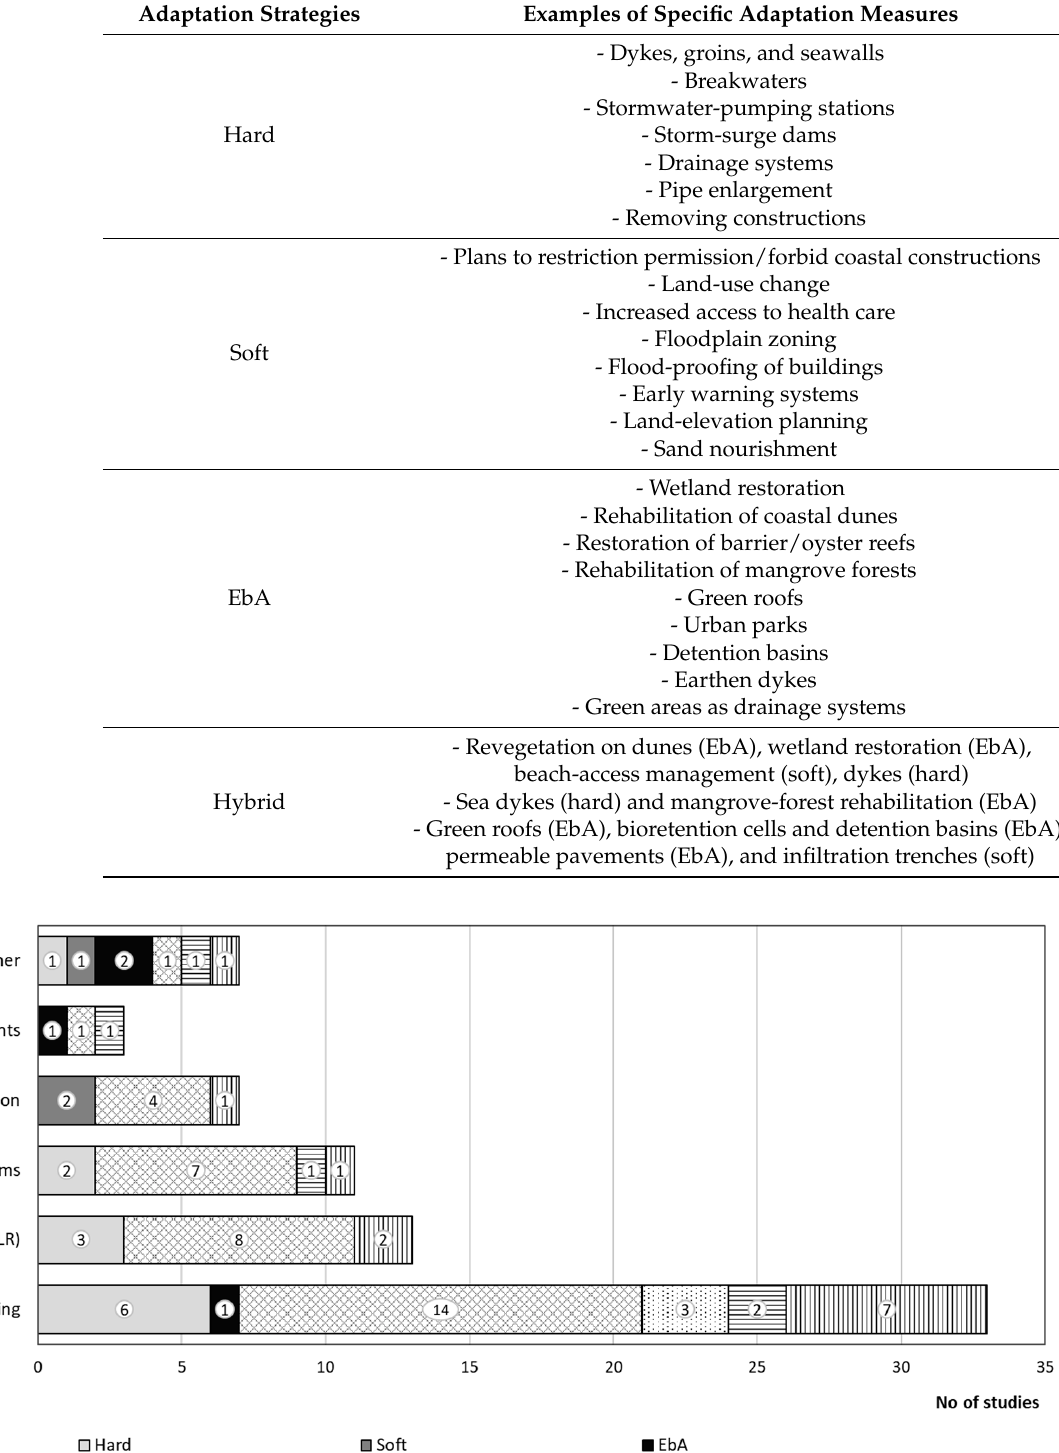
Table 6. Examples of adaptation measures addressed in the reviewed studies.